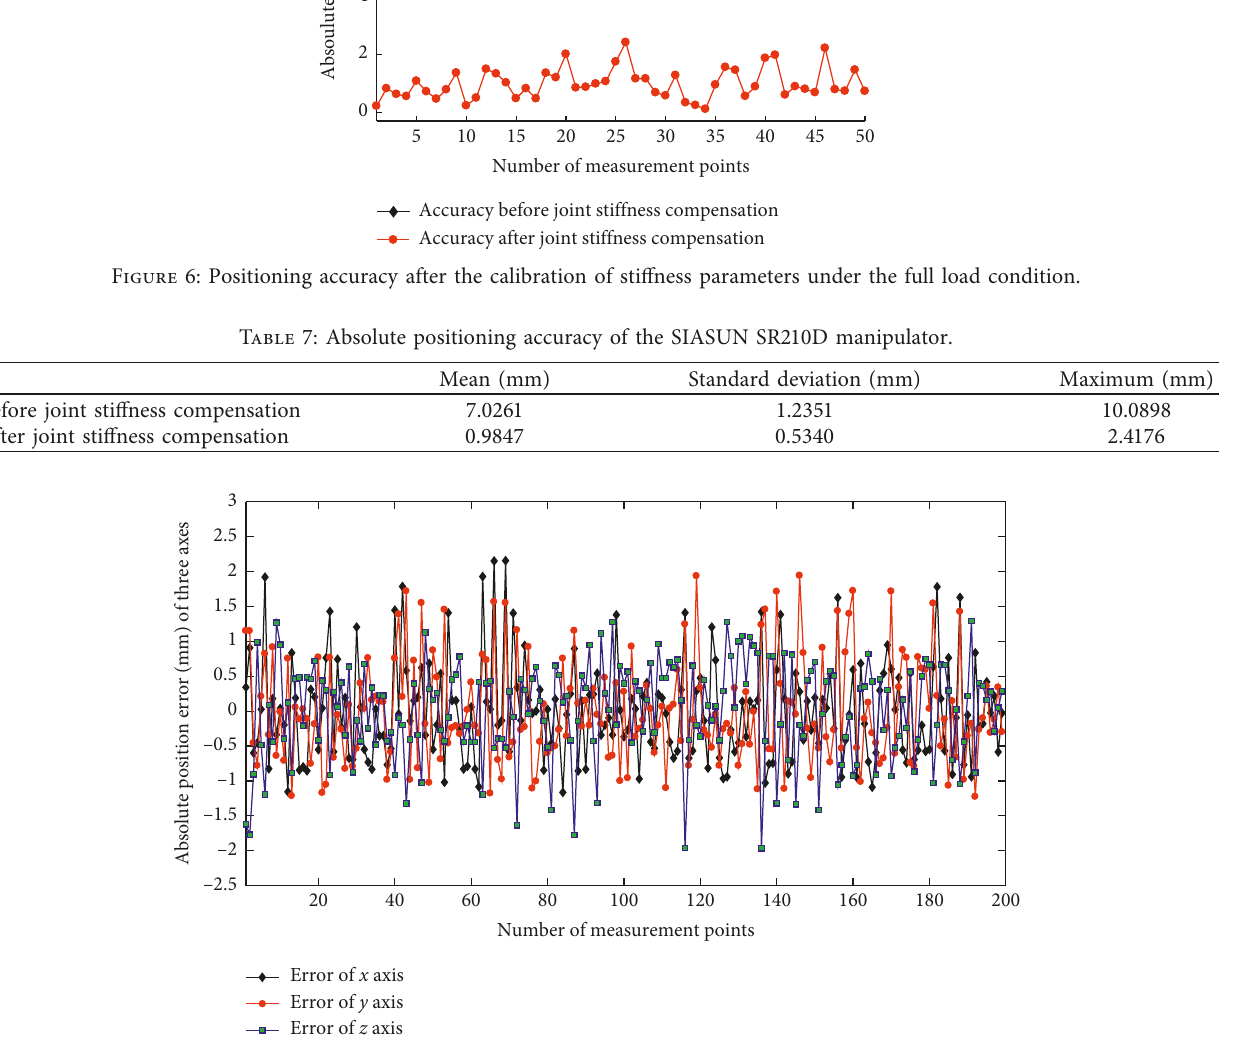
Figure 7: Residual positioning errors in each